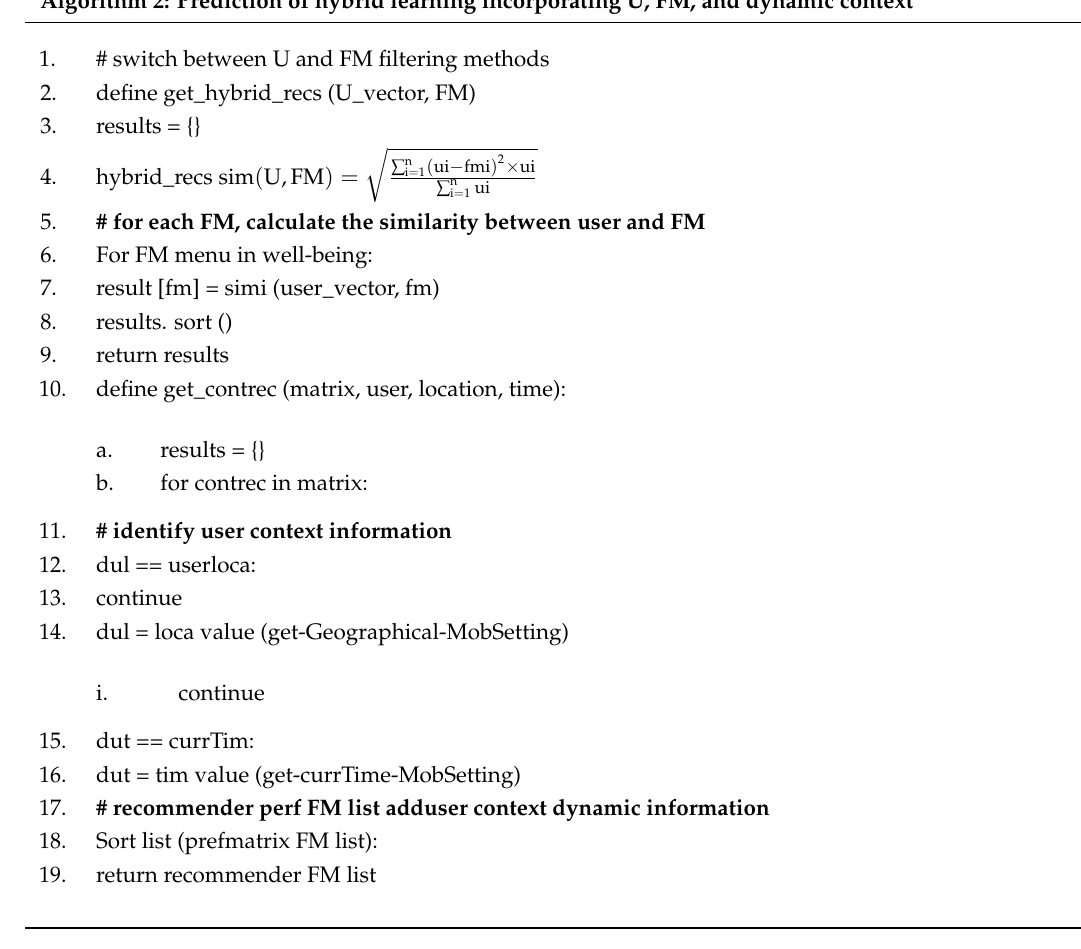
Algorithm 2: Prediction of hybrid learning incorporating U, FM, and dynamic